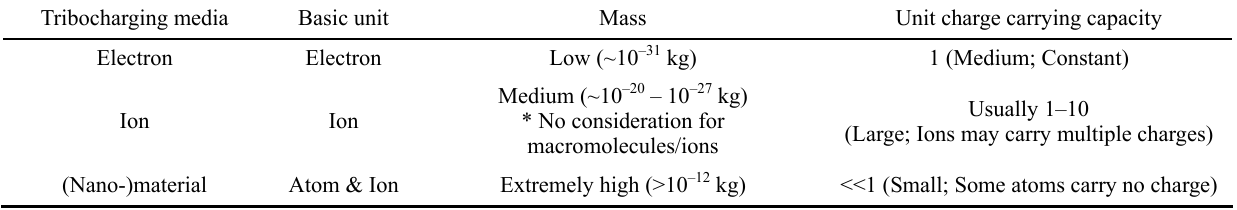
Table 1 The general difference among electron, ion, and (nano-)material. Tribocharging